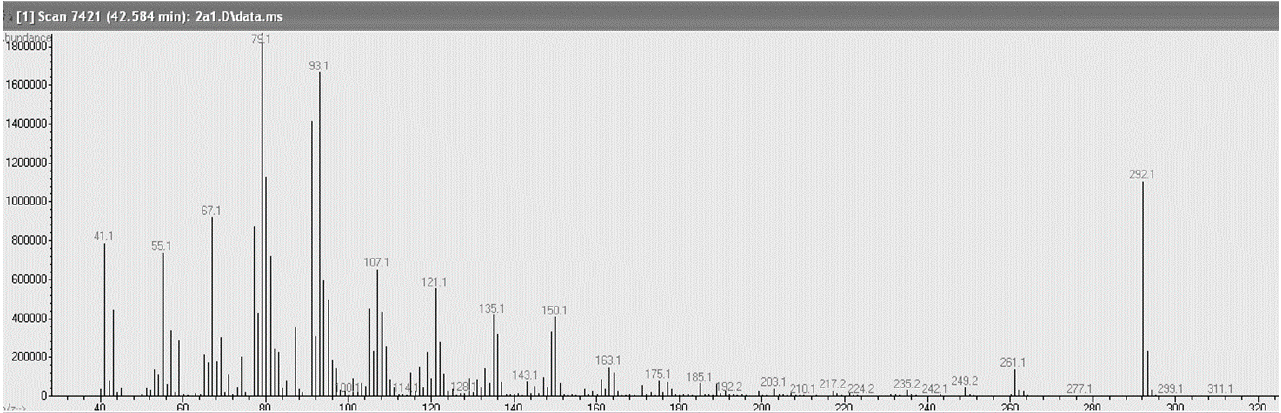
Figure 1. The GC-MS spectra of α -eleostearic acid methyl ester. The masses 41, 55, 67, 79, 93, 107, 121, 135, 150, 163, 185, 261, and 292 and their relative intensities are very specific for α -eleostearic acid methyl ester as observed by Dyer, 2003 [18].